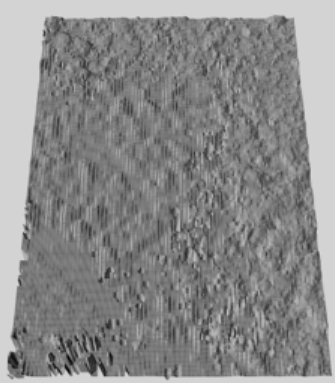
Figure 12 Combined ADS- and LiDAR-DSM "cloud" (oblique view)